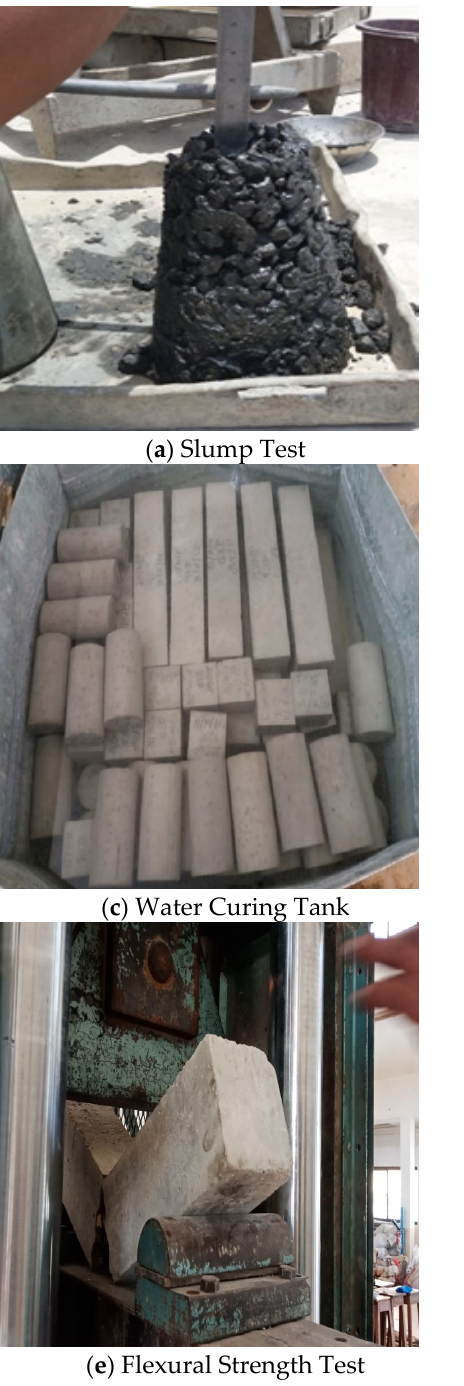
Figure 3. Experimental details of concrete testing.